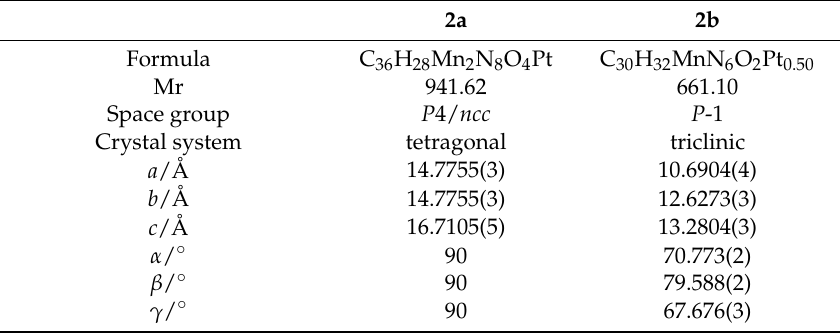
Table 1. Crystal data and structure refinements for 2a and 2b .